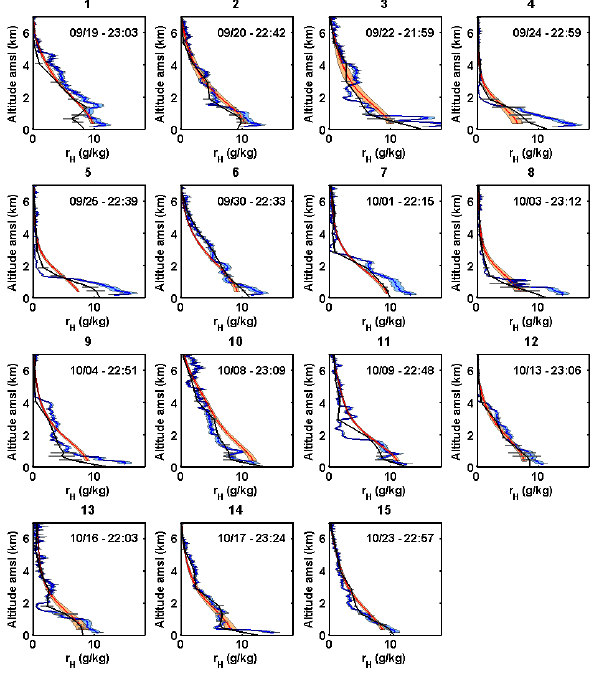
Figure 2. Comparisons of WVMR vertical profile retrieval as a function of altitude between: IASI (red), WALI lidar (blue) and ECMWF analysis (black), over Menorca during the HyMeX experi- ment (September and October 2012). The date and time of the IASI and WALI measurements are also given for each panel of individual profile in the form month/day HH:MM. The CN is given at the top of each